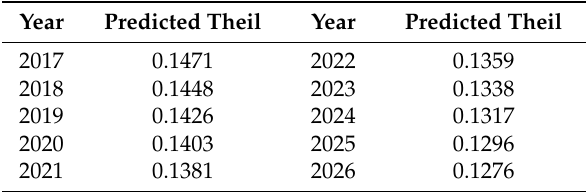
Table 2. The predicted Theil index of Chinese provincial community health service efficiency (2017–2026).